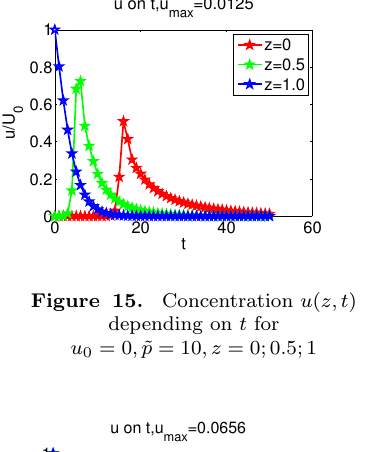
Figure 16. Concentration a ( z,t ) depending on t for u 0 = 0 , ˜ p = 10 ,z = 0;0 . 5;1